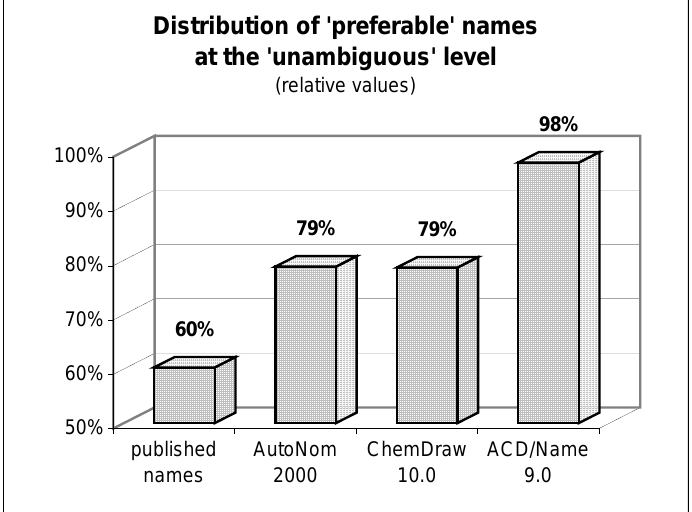
Figure 3 . Quality of the unambiguous